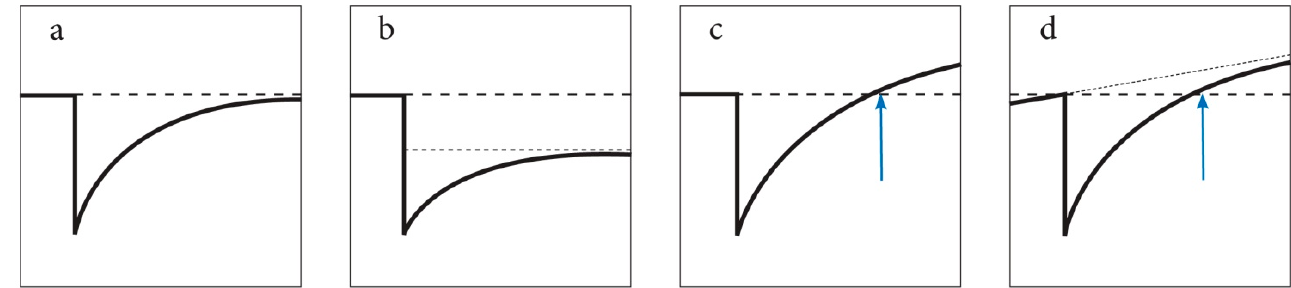
Figure 6. Different models of disturbance response relative to the pre-disturbance state (baseline). ( a ) Asymptotic model with a quasi-equilibrium state. ( b ) Long-lasting degradation with alternative quasi-equilibrium state. ( c ) Overcompensation; arrow: recovery time. ( d ) Recovery with simultaneous maturation of the undisturbed control; in this case, the recovery time (blue arrow) is distinct from the time when the disturbed system reaches the level of the control. x -axis: time; y -axis: system state (successional index or any adequate biological attribute).